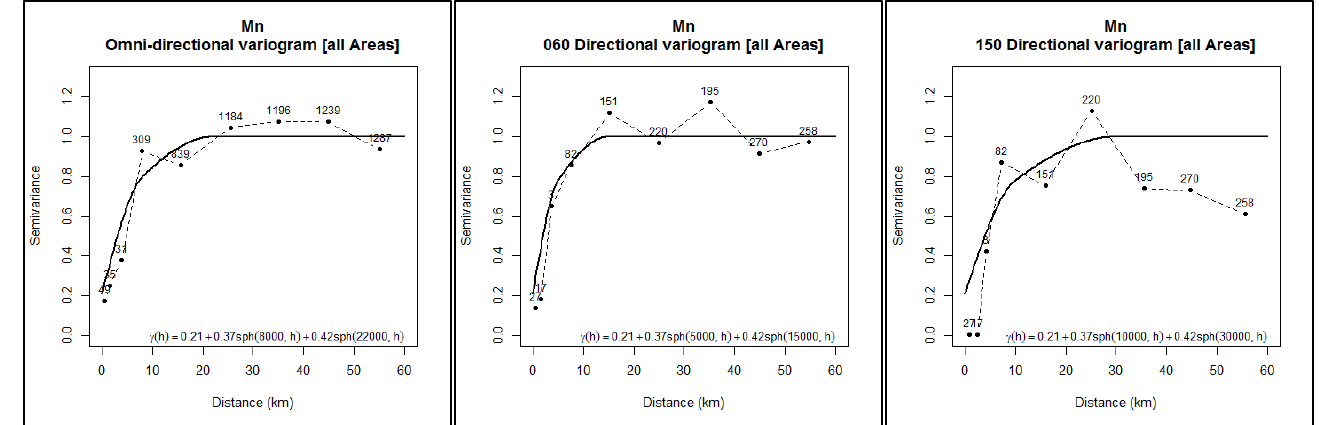
Figure 26. Mn omni-directional, 060° and 150° directional variograms. Source: [12].